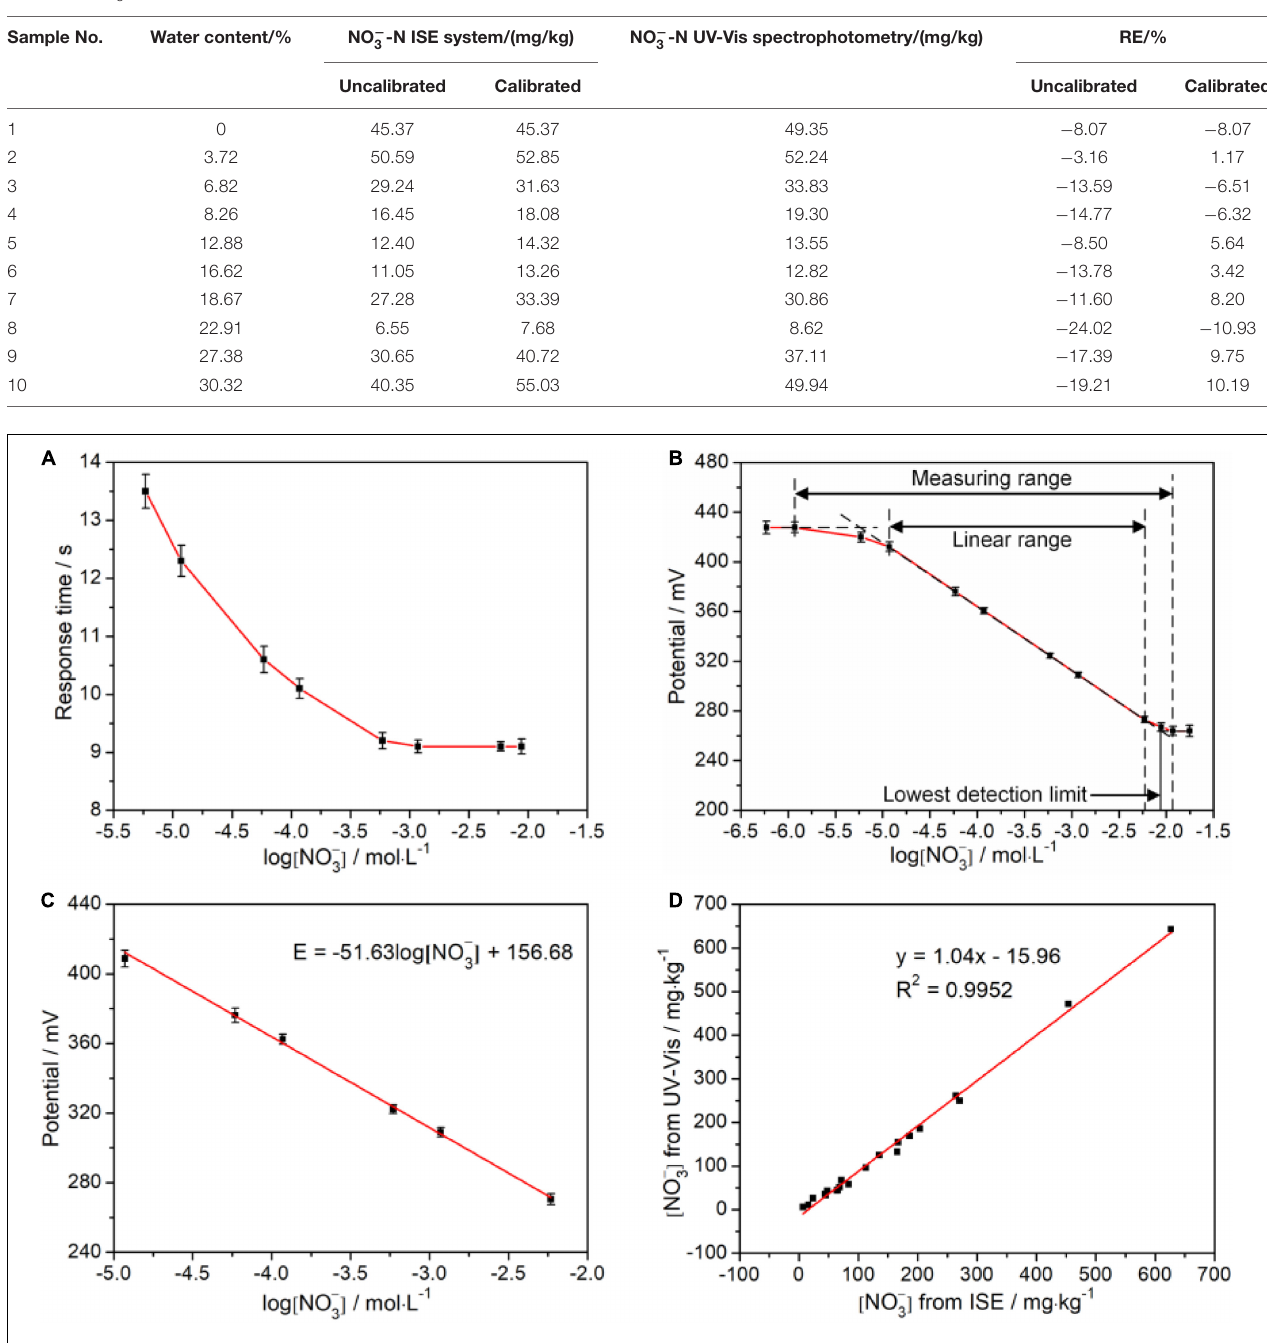
FIGURE 5 | Validation analyses of the ion-selective electrode (ISE) system. (A) Response time; (B) Linear range; (C) Response potential; and (D) Correlation between the results from ISE system and UV-Vis spectrophotometry. The (NO − 3 ) used in (A–C) is derived from standard solution. The (NO − 3 -N) used in (D) is derived from the soil sample